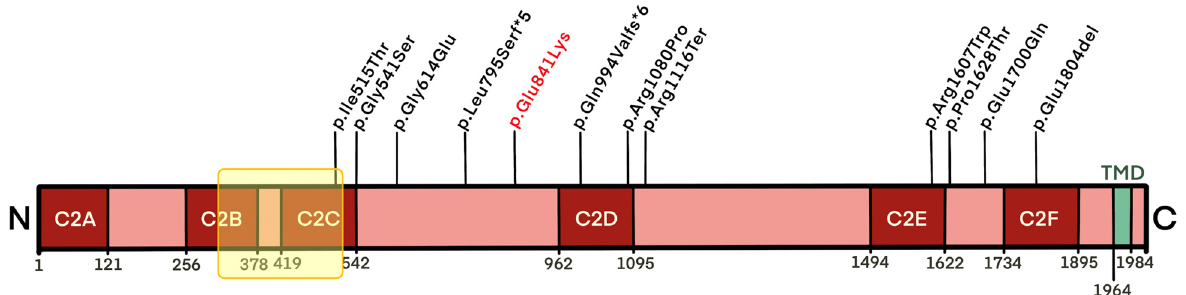
Figure 4. Mutations in the OTOF gene carried by TS-ANSD patients. The numbers were based on the amino acid sequence of human otoferlin and C2 domains (C2A to F) and the transmembrane domain (TMD) is depicted according to an in silico analysis [2]. The point mutation reported in the present study is indicated in red. The protein area affected by the deletion is indicated in yellow.